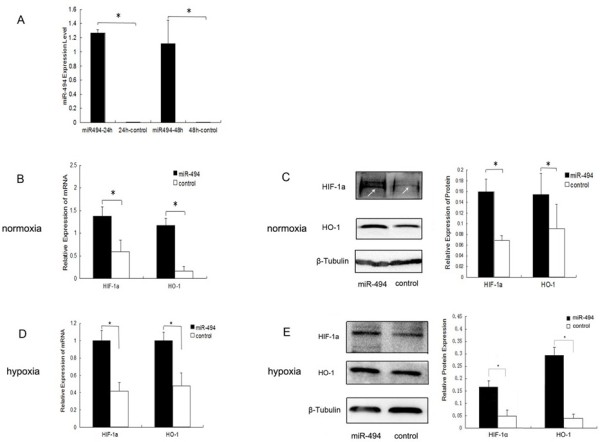
Overexpression of miR-494 increased HIF-1α and HO-1 expression under both normoxia and hypoxia. (A) Expression of miR-494 in transfected L02 cells. L02 cells were transfected with either miR-494 mimic or miR-negative control at 200 nM under normoxia. MiR-494 levels were analyzed by real-time qRT-PCR at 24 hours for transfection and 48 hours for transfection, respectively. (B-C) Expression of HIF-1α and HO-1 in transfected L02 cells under normoxia. L02 cells were transfected with either miR-494 mimic or miR-negative control at 200 nM under normoxia. After transfection for 48 hours, total RNAs and proteins were extracted and subjected to real-time qRT-PCR (B) or western blot assay (C. Left: Western blot analysis for HIF-1α, HO-1 and β-Tubulin. The sample loading of protein for normoxic condition was 80 μg. The signal indicated by white arrow is HIF-1α. Right: Densitometric analysis using Quantity one software in left). (D-E) Expression of HIF-1αand HO-1 in transfected L02 cells under hypoxia. After transfection for 16 hours, cells were exposed to hypoxia (1%O2, 5%CO2 in a 37°C incubator) for 8 hours. Total RNAs and proteins were extracted, and then real-time qRT-PCR (D) and western blot (E. Left: Western blot analysis for HIF-1α, HO-1 and β-Tubulin. The sample loading of protein for hypoxic condition.was 40 μg. Right: Densitometric analysis using Quantity one software in left) were done. Control indicated miR-negative control. The quantitative data for western blot were normalized by the level of β-Tubulin expression. The data were presented as the means ± SD. Columns, mean of three independent experiments; bars, SD; *p < 0.05.